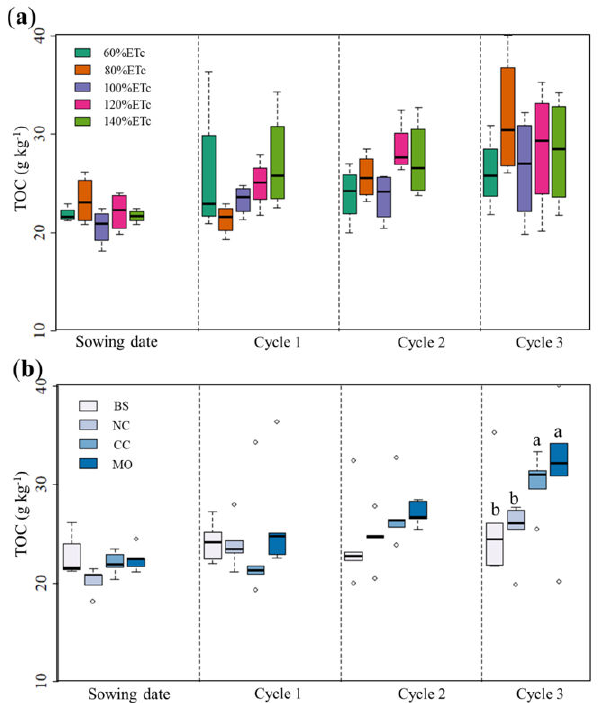
Figure 9. Boxplot of total organic carbon concentration (TOC) as a function of irrigation depths (for 60%, 80%, 100%, 120%, and 140% ETc) with wastewater ( a ), and as a function of the soil cover conditions, bare soil (BS), natural cover (NC), coconut coir (CC), and moringa (MO) ( b ). Mean values were compared using Tukey’s test ( p < 0.05) and are indicated by lowercase